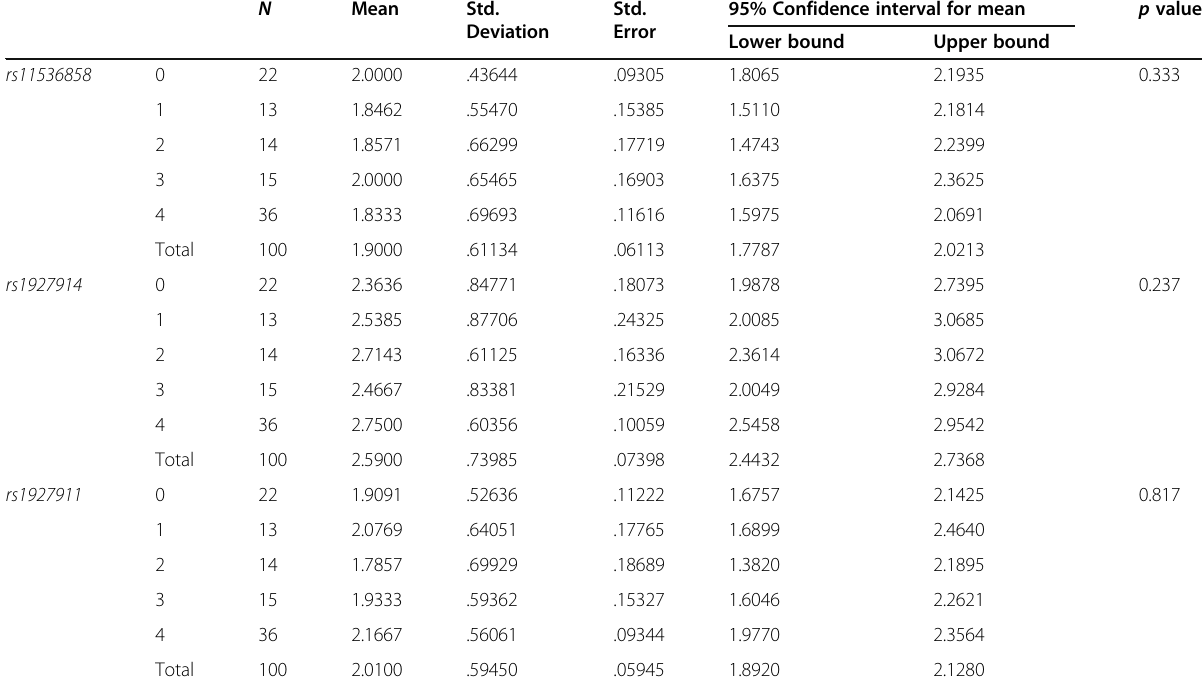
Table 8 Association of the TLR4 SNPs with the VIDA score of